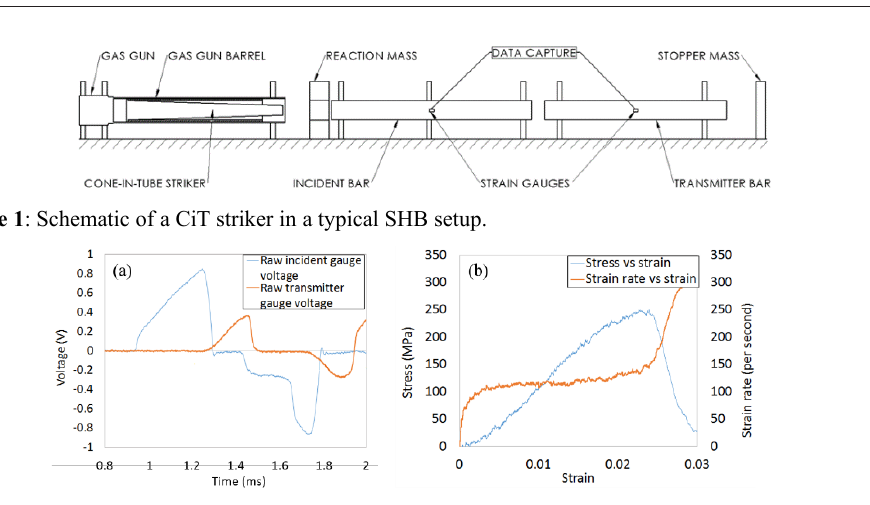
Figure 2 : Examples of (a) a raw SHB signal showing voltage over time, and (b) the final processed SHB signal showing the constant strain rate obtained using a CiT